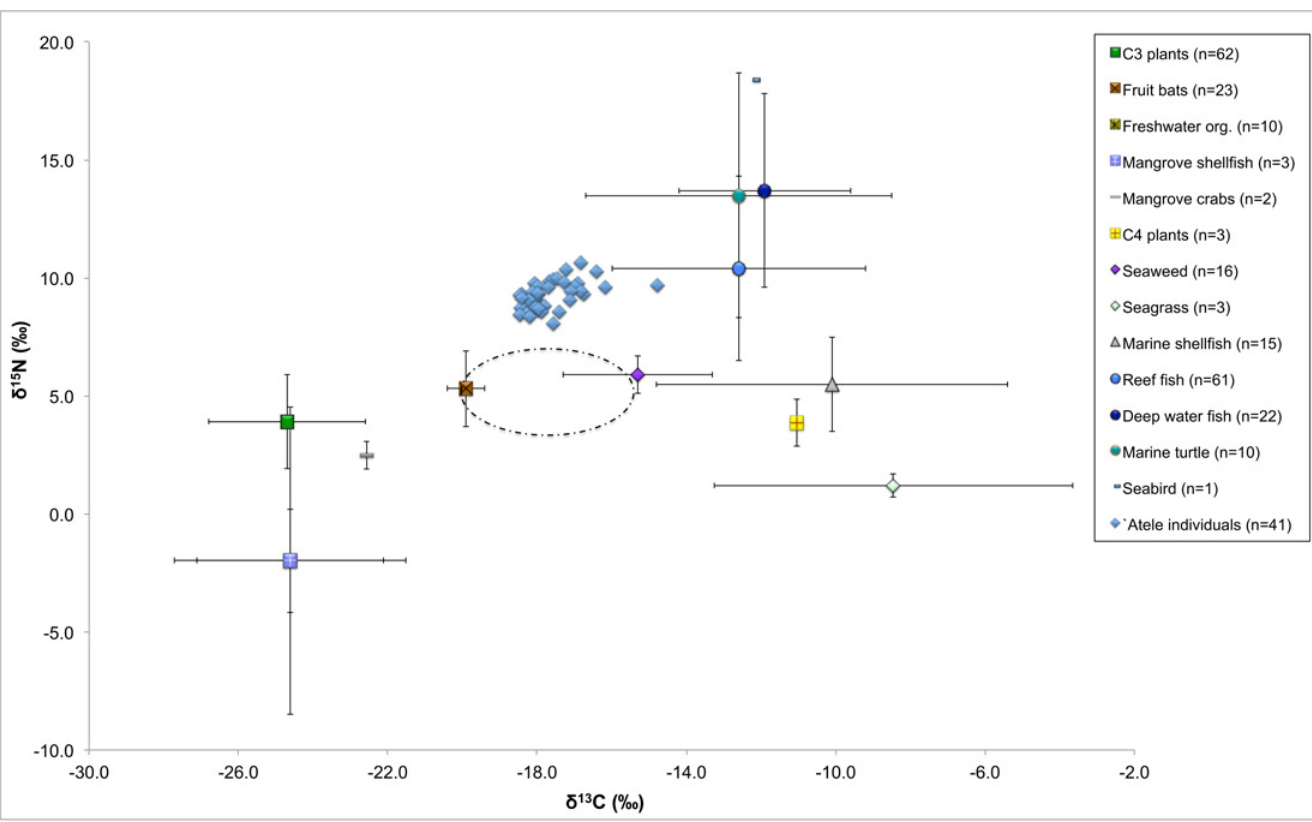
Fig 10. The `Atele δ 13 C and δ 15 N values compared to dietary baseline data from previous studies [71,82] Modern δ 13 C values have been corrected for the Suess effect, but are otherwise unaltered. The dashed circle indicates the diet of the individuals once corrected for trophic level, 1 ‰ for δ 13 C and 4 ‰ for δ 15 N